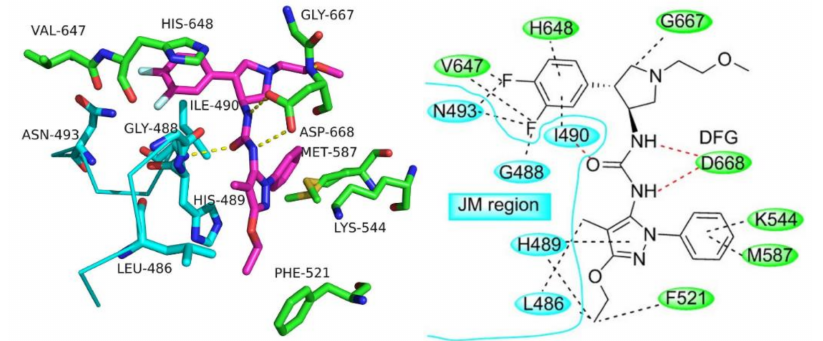
Figure 93. The in silico binding interactions of compound 86 with the juxtamembrane region of TrkA kinase